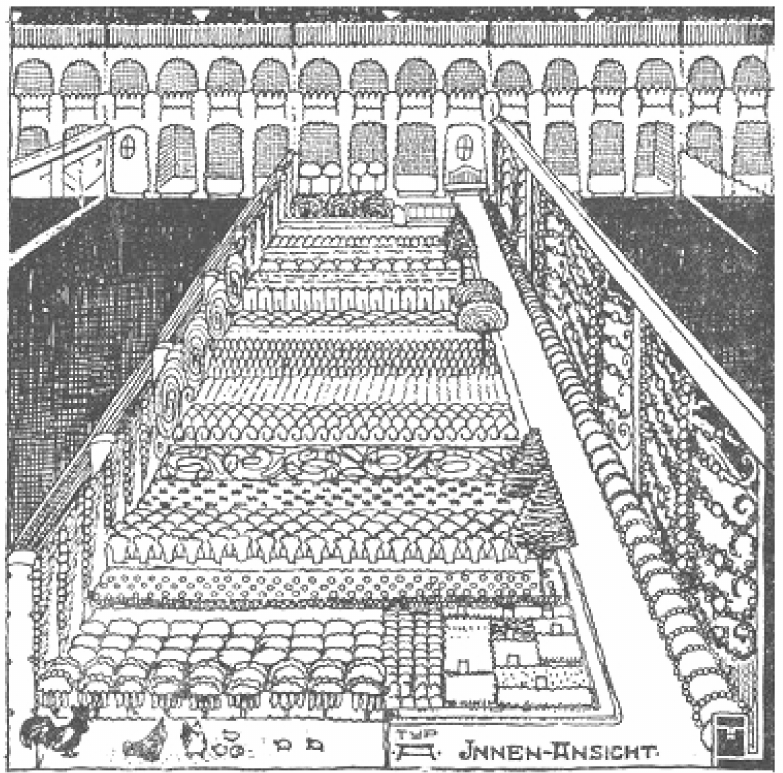
Figure 2. View of a vegetable garden situated behind the residential building (Germ. Siedlung , by Migge L., 1919), Leberecht Migge, 1919b, p.